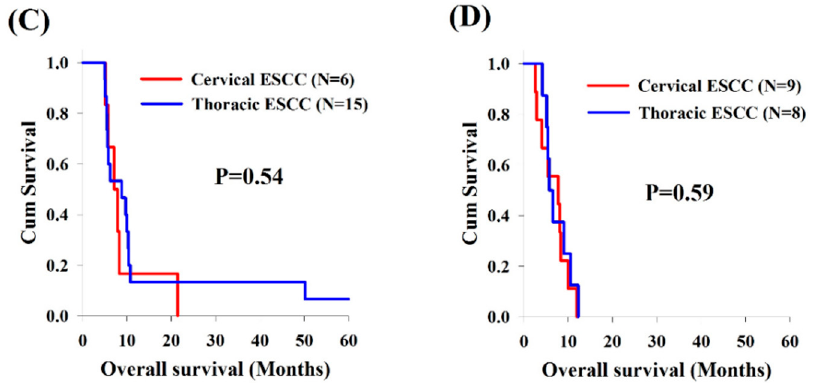
Figure 2. Comparison of overall survival between patients with cervical and thoracic esophageal squamous cell carcinoma according to treatment responses: ( A ) complete response; ( B ) partial response; ( C ) stable disease; and ( D ) progressive disease.